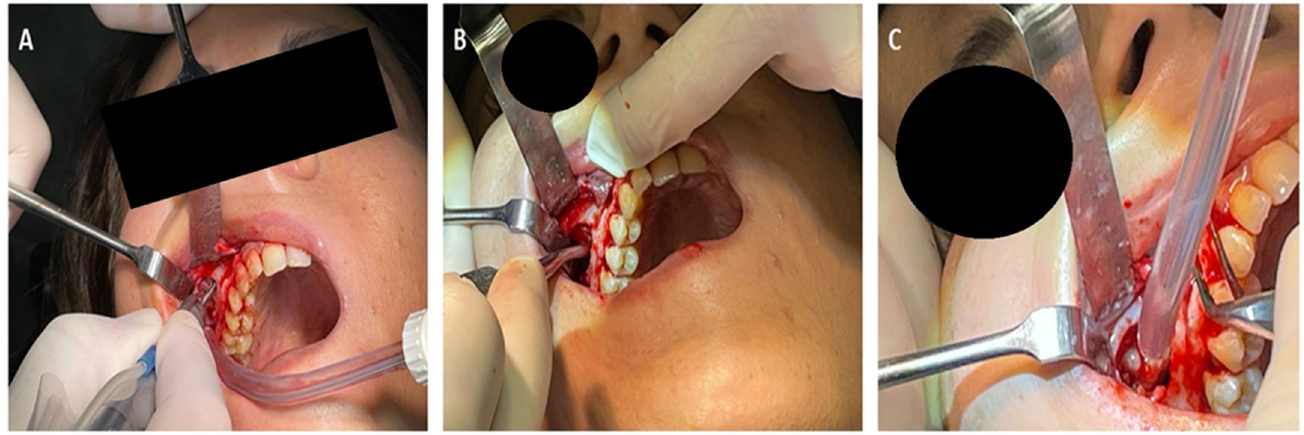
Figure 3. A modified triangular flap without anterior release was performed for access to the sinus maxillary ( A ). A window by rosette round bur was opened in the posterior part of the maxillary sinus ( B ). After dislocation the wisdom tooth was aspirated ( C ).